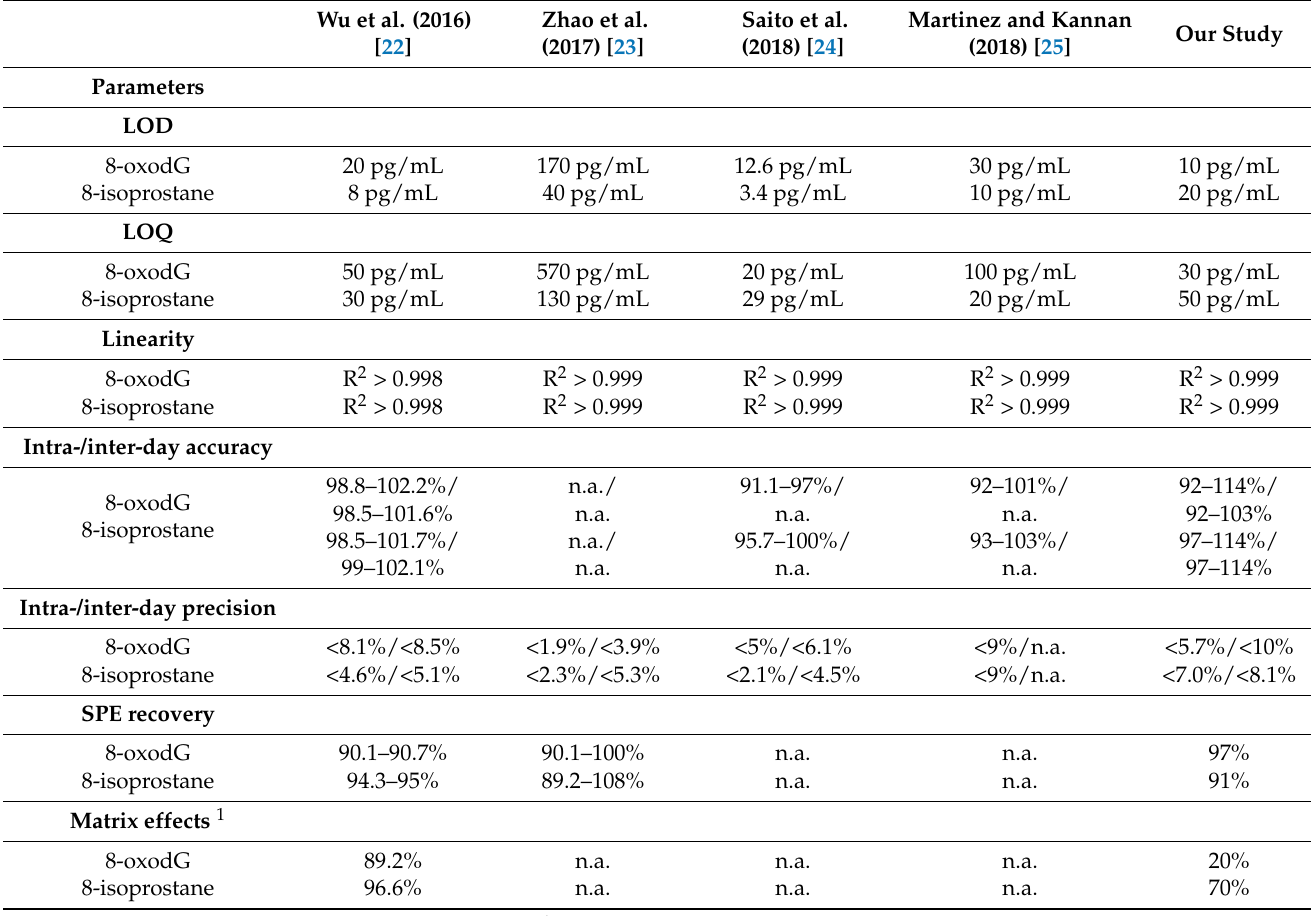
Table 1. Descriptions of the multi-analyte analytical methods previously developed and our